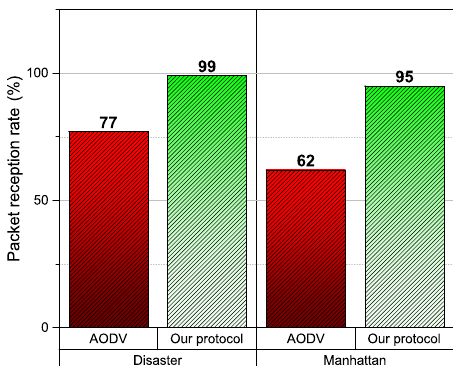
Figure 11. Statistical evaluation